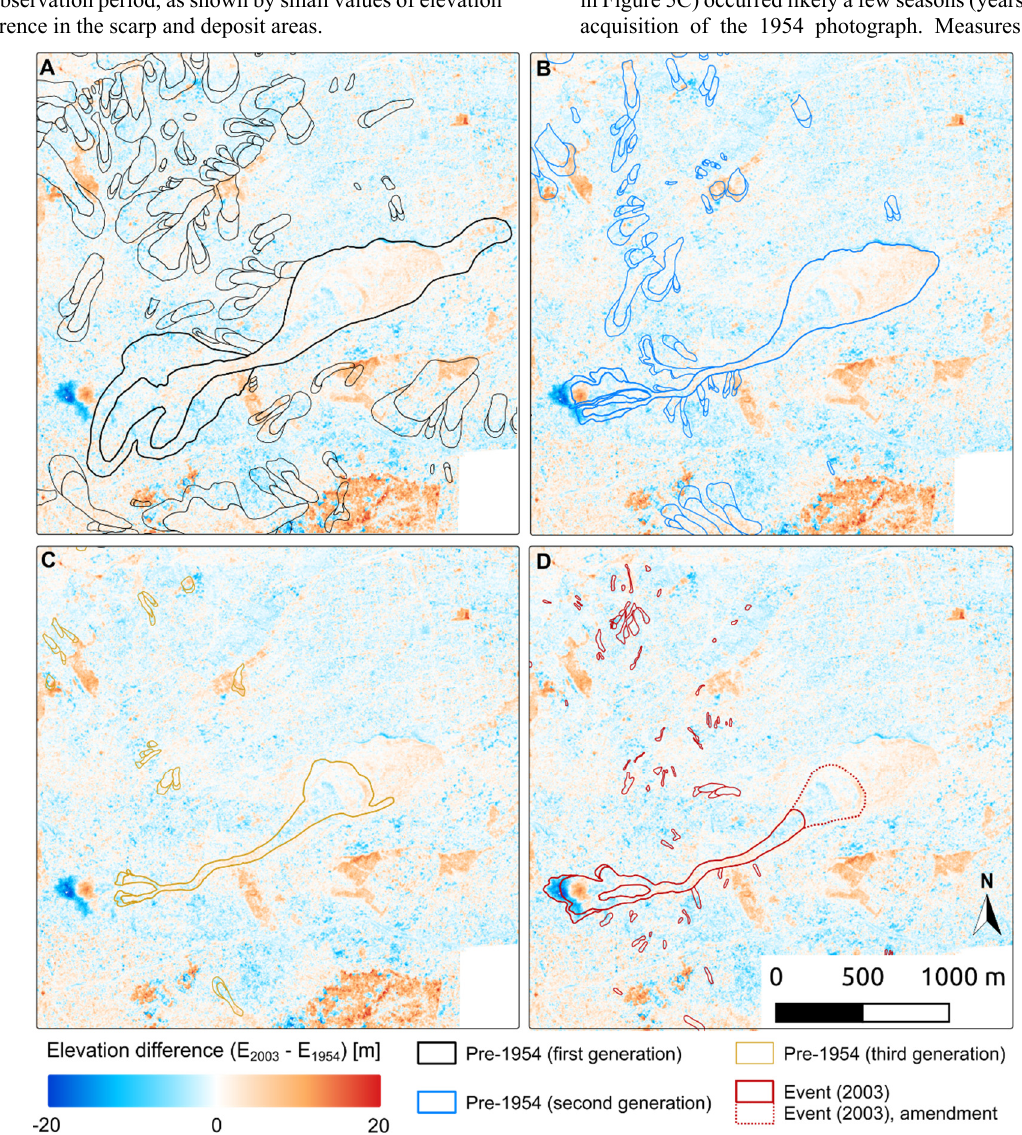
Figure 5. Landslide inventory divided by relative age classification (i.e., generations) and compared to the DoD obtained by the automatic pipeline. Thicker polygons indicate the Alberona test case landslide. (A), (B) and (C) First, second and third generation landslide(s). (D) Landslide event occurred in 2003, and amendment based on the results of the photogrammetric